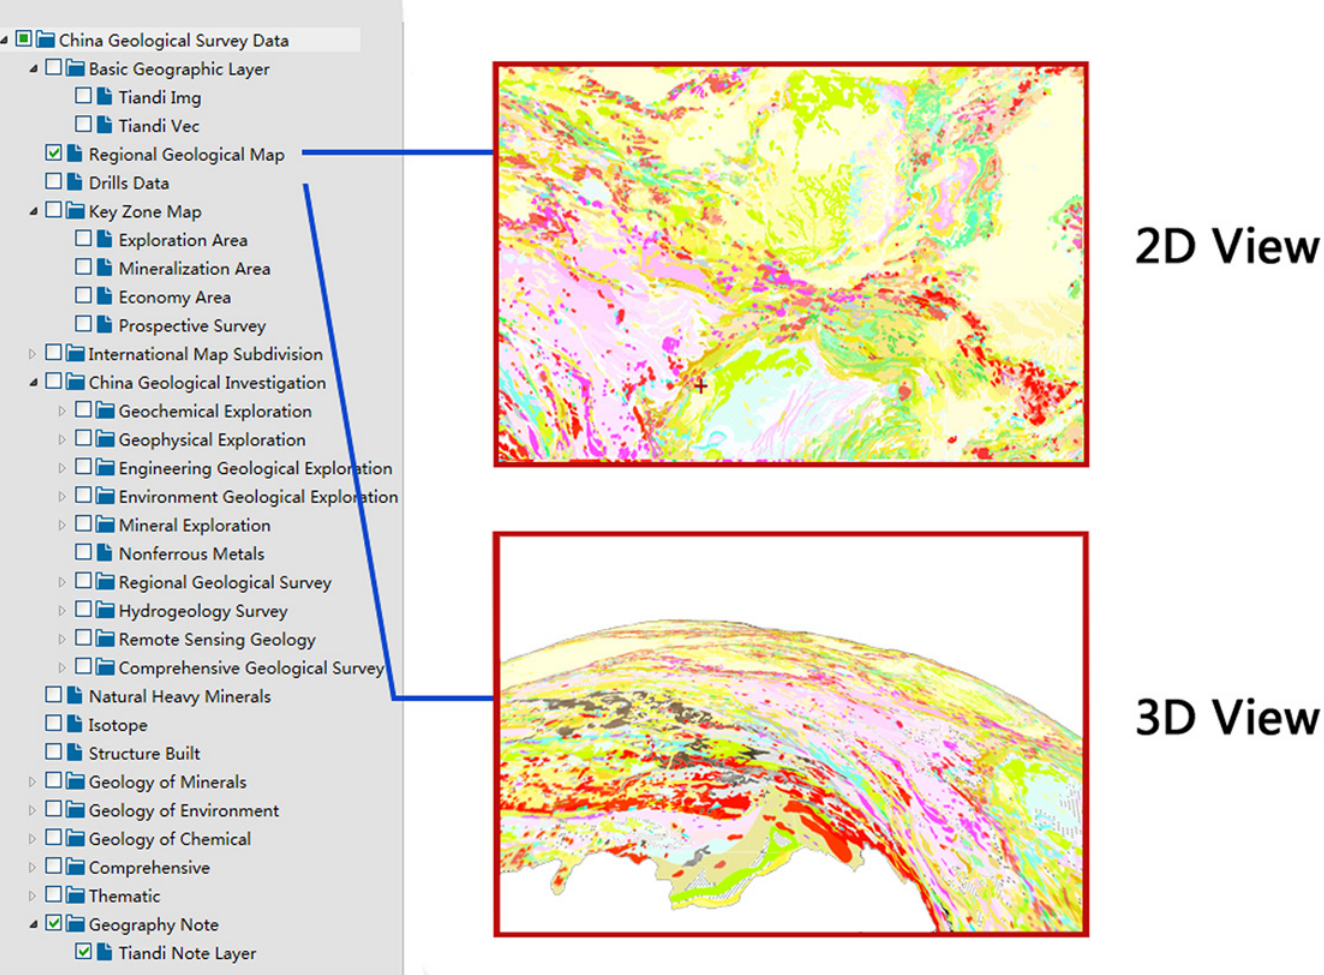
Fig 12. Distributed multi-source, multi-scale geological grid stream